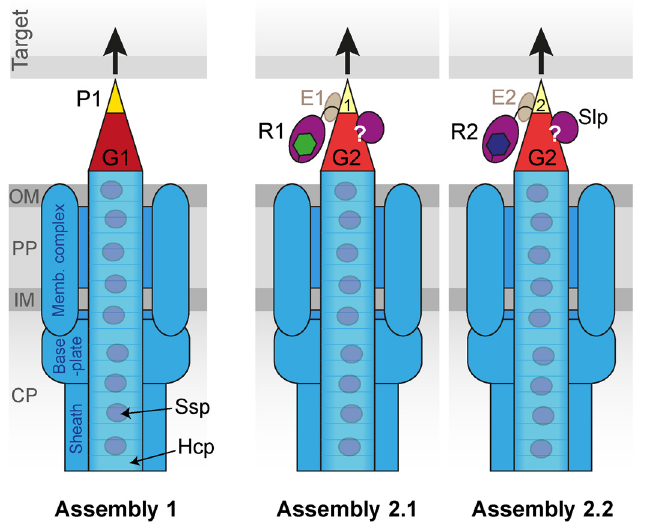
Fig 8. Schematic representation of the three distinct assemblies formed by the T6SS of S . marcescens . Assembly 1 utilises VgrG1 (G1) and a small, dedicated PAAR protein (Paar1, P1). Assemblies 2.1 and 2.2 both include VgrG2 (G2) together with either Rhs1 (R1; Assembly 2.1) or Rhs2 (R2, Assembly 2.2), with the Rhs proteins supplying their N-terminal PAAR-containing domains (yellow), each bound by the cognate EagR protein (E1 or E2). The VgrG2-specific effector Slp can be delivered by either 2.1 or 2.2 but it is not yet clear whether this is through a direct interaction between Slp and VgrG2 or via an intermediary protein (indicated by ‘ ? ’ ). If any of the three assemblies are intact, the system can fire and Hcp-dependent cargo effectors can be delivered. However delivery of some, if not all, of these cargo effectors is more efficient using VgrG2, and delivery of at least Ssp4 and Slp is more efficient using Assembly 2.2 than 2.1. VgrG proteins, red; PAAR proteins or PAAR repeat containing domains, yellow; effector proteins or domains, violet, with the exception of Rhs C-terminal domains which are green or dark blue; conserved T6SS components, blue. Compartments of the secreting cell: OM, outer membrane; PP, periplasm; IM, inner membrane; CP,